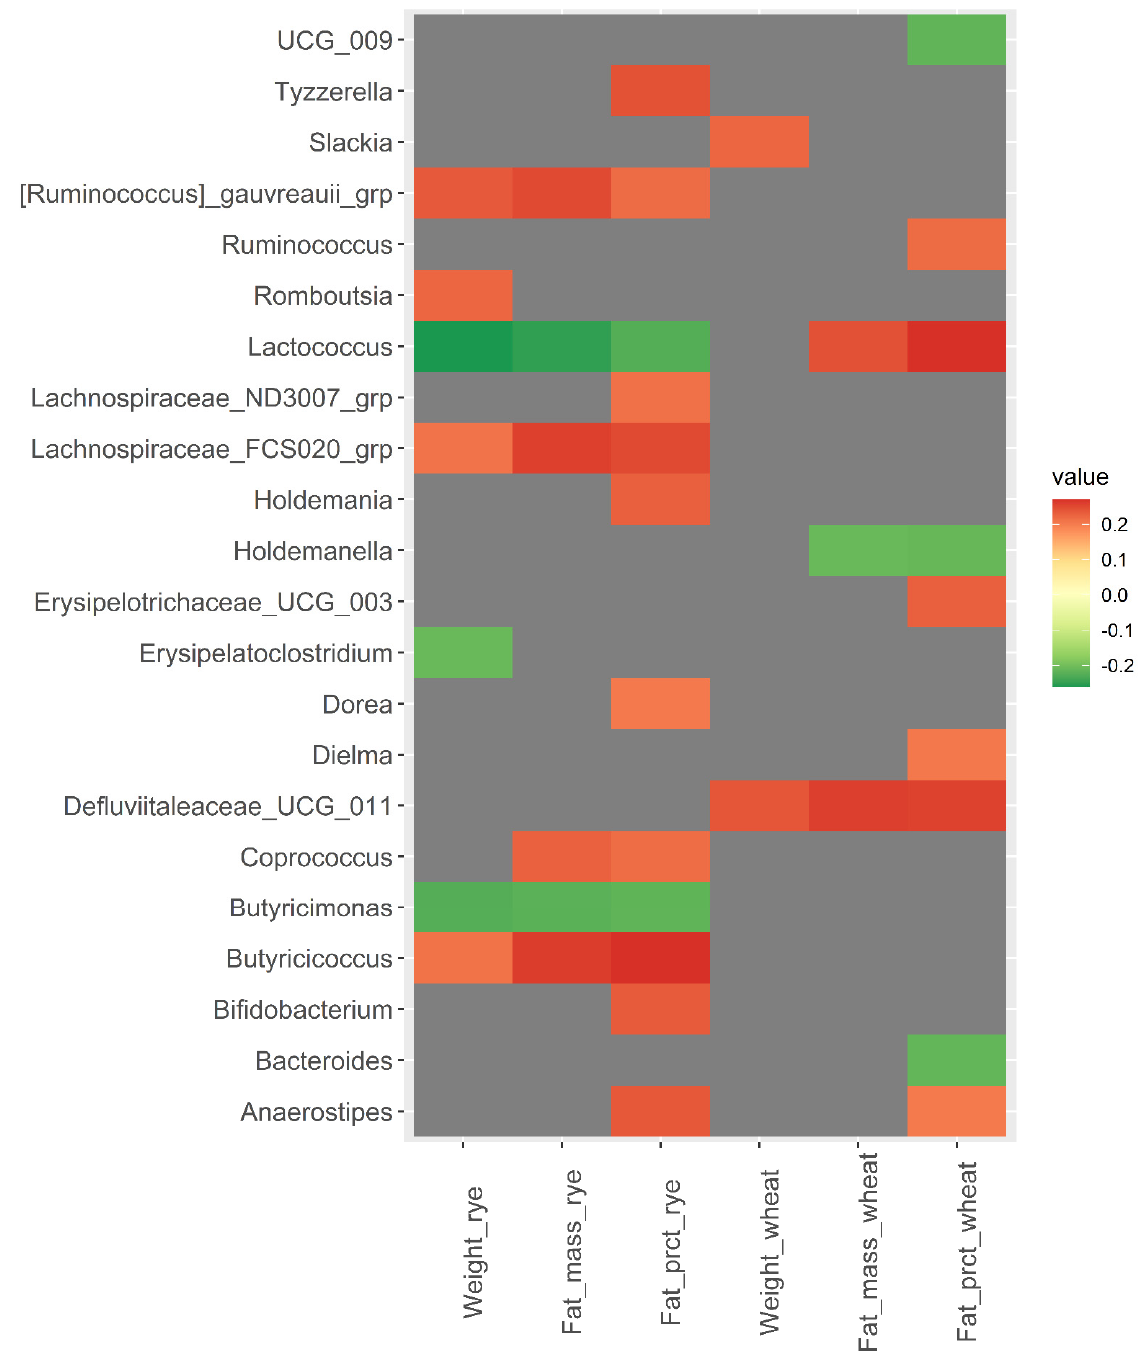
Figure 2. Heatmap of correlations (Spearman’s rho ) between bacterial abundance at baseline and changes in body weight, body fat mass, and body fat percentage over 12 weeks within the wheat group and the rye group. Only significant correlations with Spearman’s rho ≥ |0.200| are included in the heatmap, while correlations for all 110 bacteria are shown in Supplementary File S2.